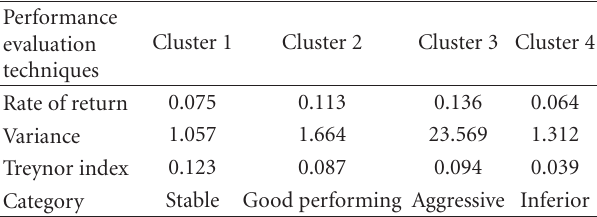
Table 1: Summary of Cluster Analysis